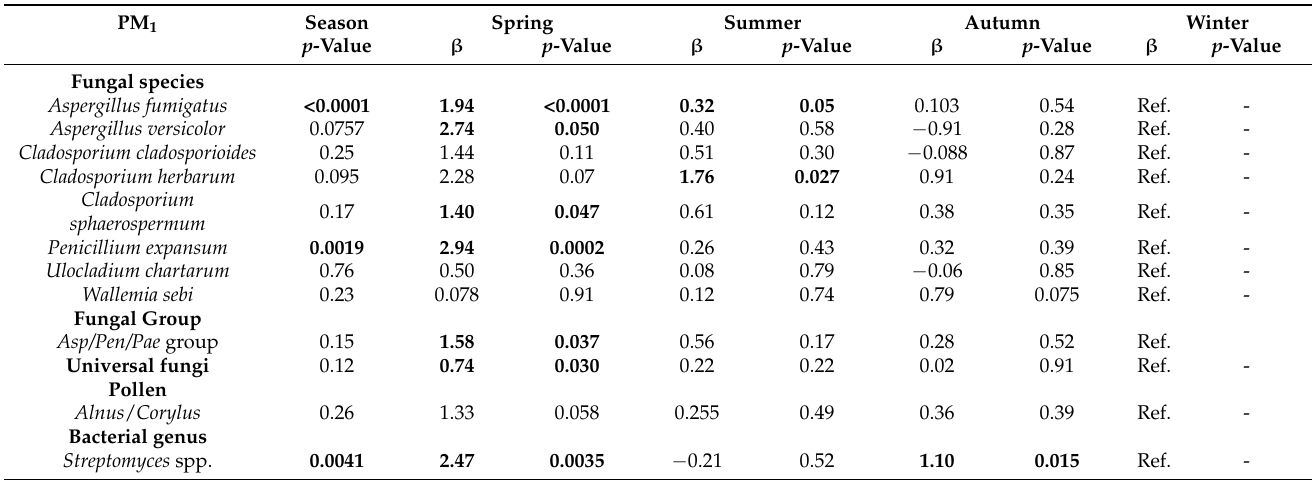
Table 2. Seasonal differences between the concentrations of DNA copies in PM 1 samples positive for fragments.